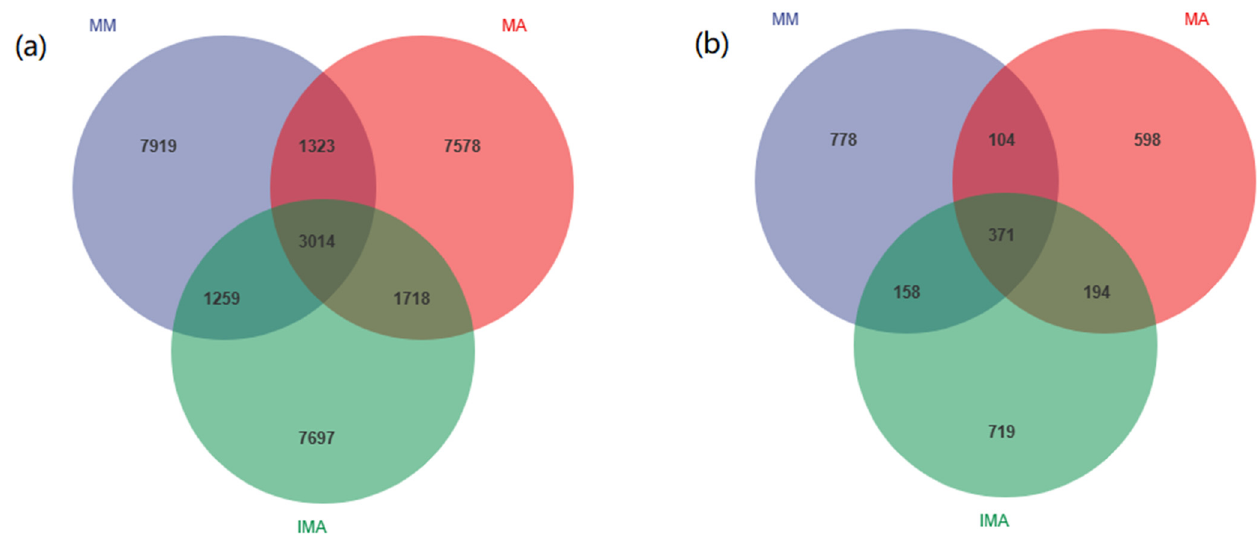
Figure 1. OTUs Venn diagrams. ( a ): OTUs detected in bacteria; ( b ): OTUs detected in fungi. MM: